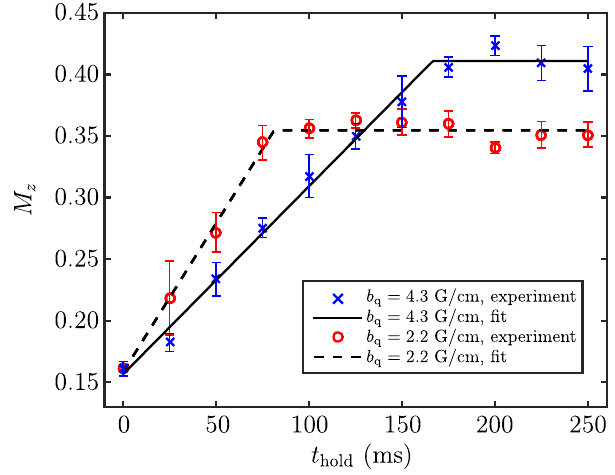
FIG. 6. Magnetization parameter M as a function of hold z time t . Blue crosses and red circles represent the mean value hold of ten individual experiments with magnetic field gradients 4 . 3 G = cm and b 2 . 2 G = cm, respectively. The error bars b q ¼ q ¼ indicate the uncertainty of 2 standard deviations of the means. The solid and dashed lines are piecewise linear fitting functions with constant